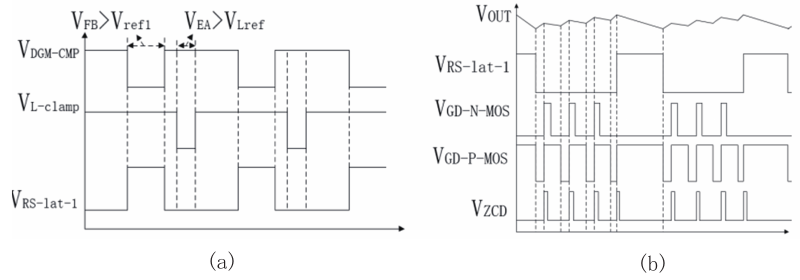
Figure 3. Main control signal timing logic. ( a ) The logical relationship between V L − clamp , V DGM − CMP and V RS − lat − 1 . ( b ) The correspondence between V OUT , V RS − lat − 1 , V ZCD , V GD − N − MOS , and V GD − P − MOS